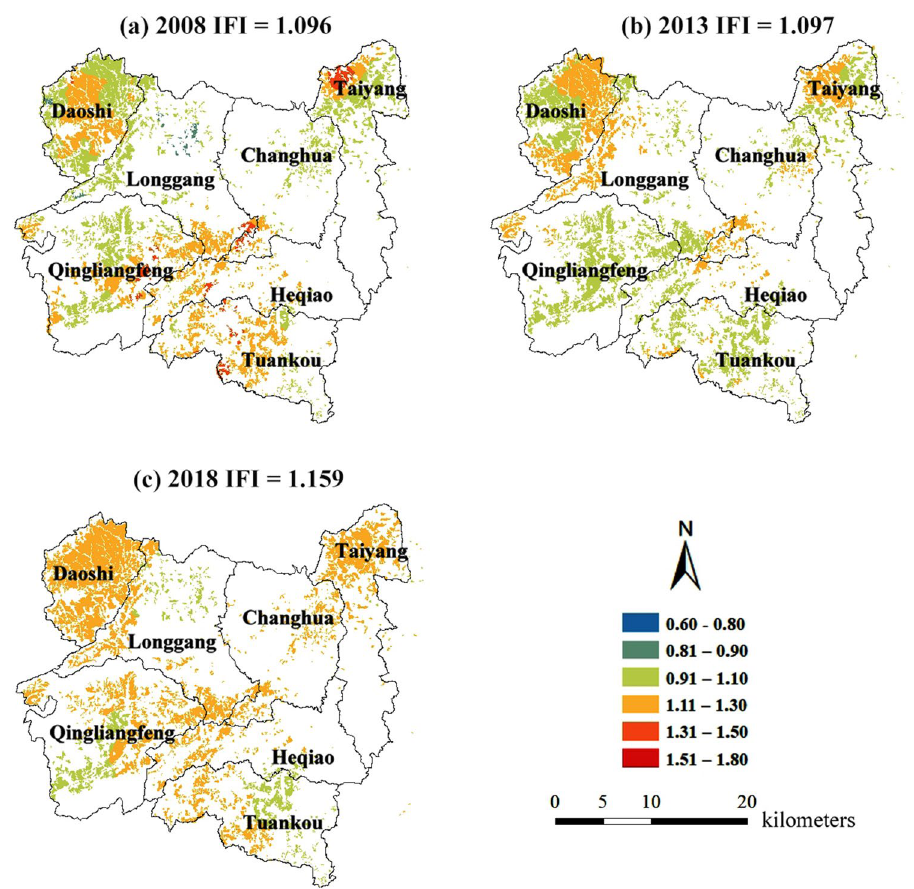
Figure 4. Soil integrated fertility index (IFI) level distribution map of the Chinese hickory plantation regions. The maps were created in ArcGIS desktop